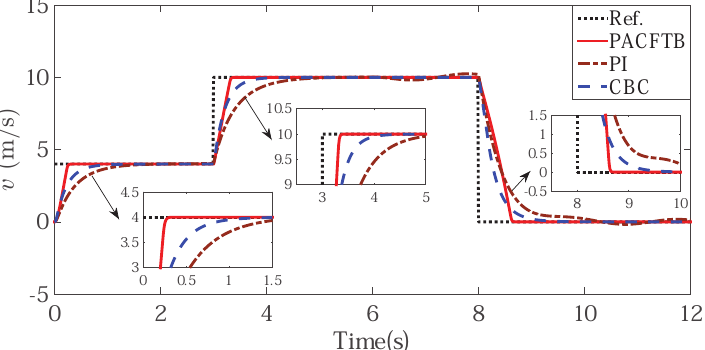
Figure 4. LIM speed tracking effect with different controller.